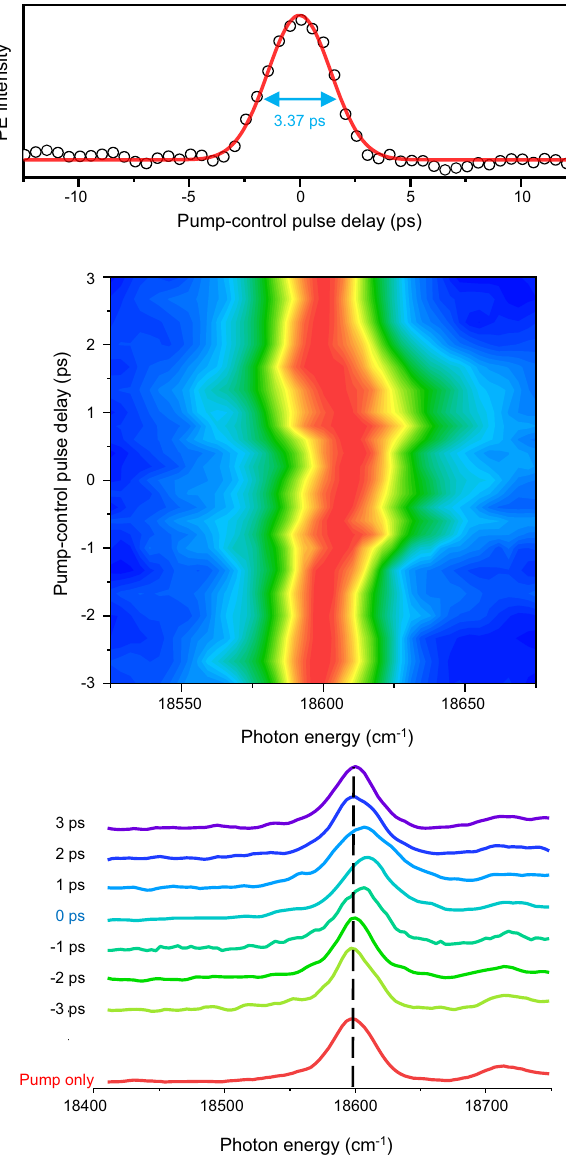
Fig. 2 Temporal (overlap between pump and control laser pulses) behavior of the ponderomotive shift. a The photoelectron transient taken by fi xing the pump laser at the blue-edge of the PhO − DBS 11 ′ 1 peak (denoted by the yellow shaded stick in Fig. 1b) while scanning the time- delay between the pump and control laser pulses. The transient was fi tted with a Gaussian function. b Photodetachment spectra of the PhO − DBS taken at various delay times between pump and control pulses. The most prominent 11 ′ 1 band (centered at ~ 18,595cm − 1 , black dashed line) shows the blue-shift and asymmetric broadening as the temporal overlap becomes maximized. The intensity of the non-resonant ps laser pulse (791 nm) was ~85 GW/cm 2 . Source data are provided as a Source Data fi le. potential energy is given as follows. 1 α E 2 ð t Þ ð 1 Þ V (cid:1) (cid:3) 4 here, α is the polarizability of the charged particle whereas E(t) is the external oscillating electric fi eld. For the free electron, α is